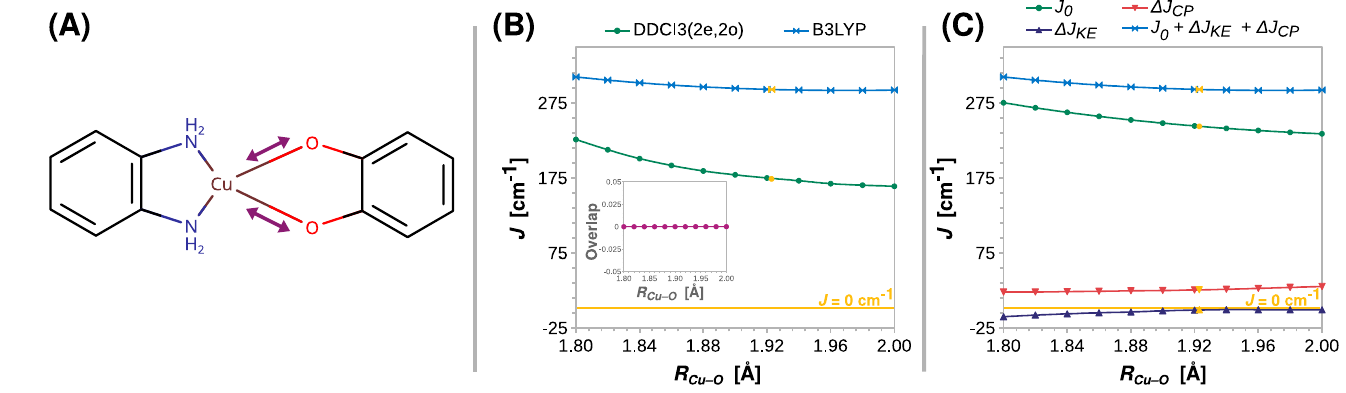
Figure 4. Rigid scan of J along the Cu–O distance ( R Cu–O ): schematic representation of the varied structural parameter ( A ); the parameter J predicted at the B3LYP and DDCI3(2e,2o) levels ( B ); decomposition of J at the B3LYP level ( C ). Inset in ( B ) shows the overlap of the magnetic orbitals calculated at the B3LYP level. All are calculated with the def2-TZVP basis set. For clarity, the line J = 0 cm − 1 is shown as a reference. For the geometry optimized at the B3LYP/def2-TZVP theory level R Cu–O = 1.925 Å (labeled with the yellow symbols).